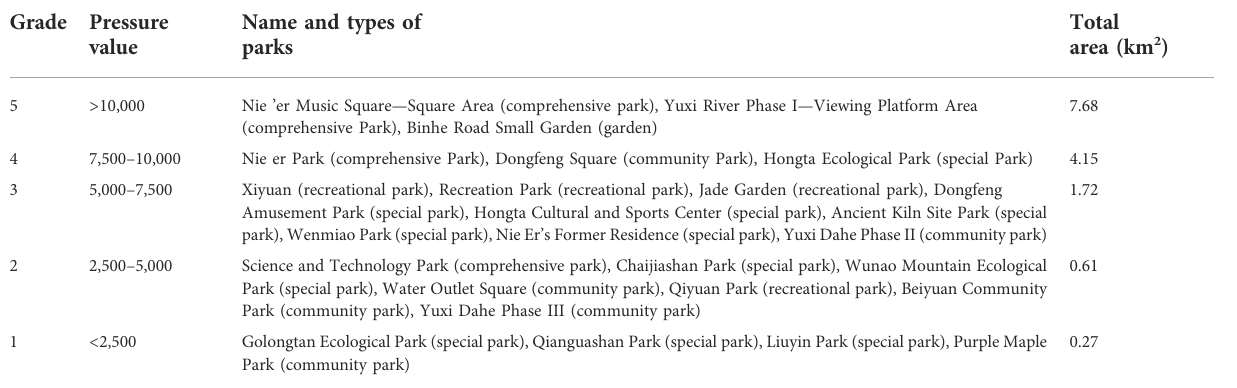
TABLE 2 Area of urban green space service pressure levels in Yuxi